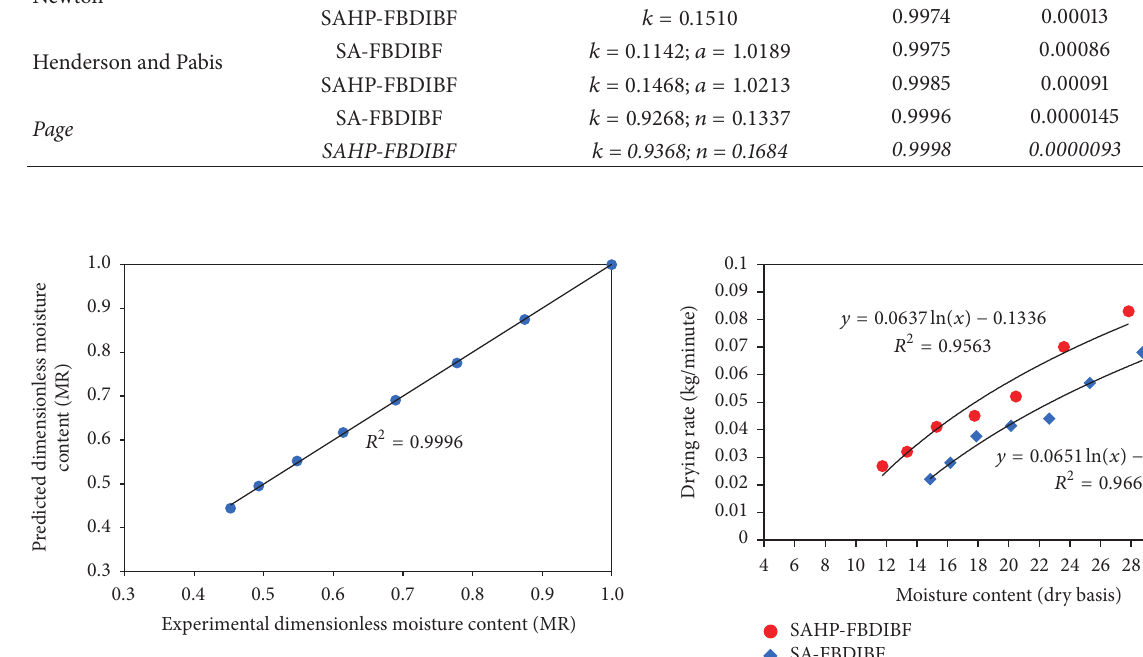
Figure 26: Comparison of experimental dimensionless moisture content (MR) with predicted dimensionless moisture content (MR) from the Page model for the SA-FBDIBF for drying of paddy.